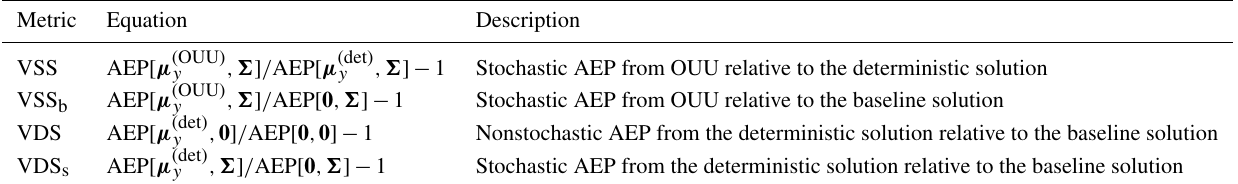
Table 1. Summary of AEP-based metrics used to assess the quality of solutions for given values of µ TI and µ α (for simplicity, these parameters are suppressed as arguments of the AEP in the notation).